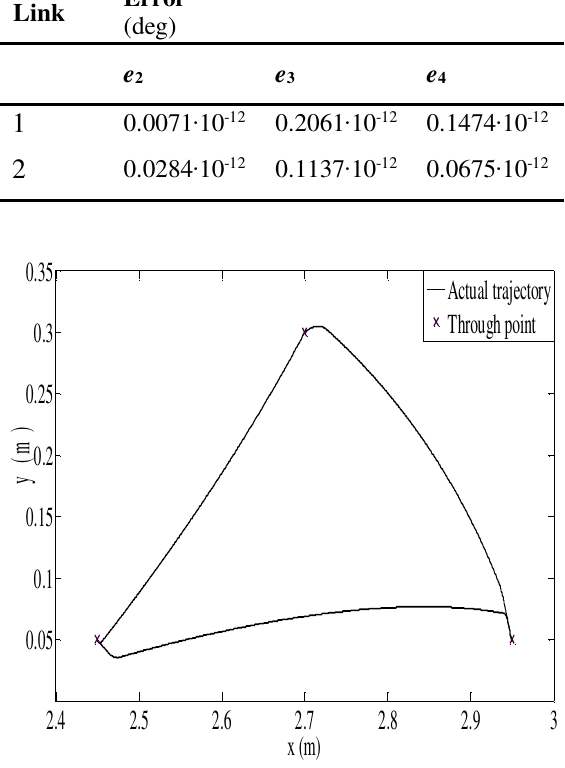
Fig. 9. Two-link Cartesian path obtained by proposed method.